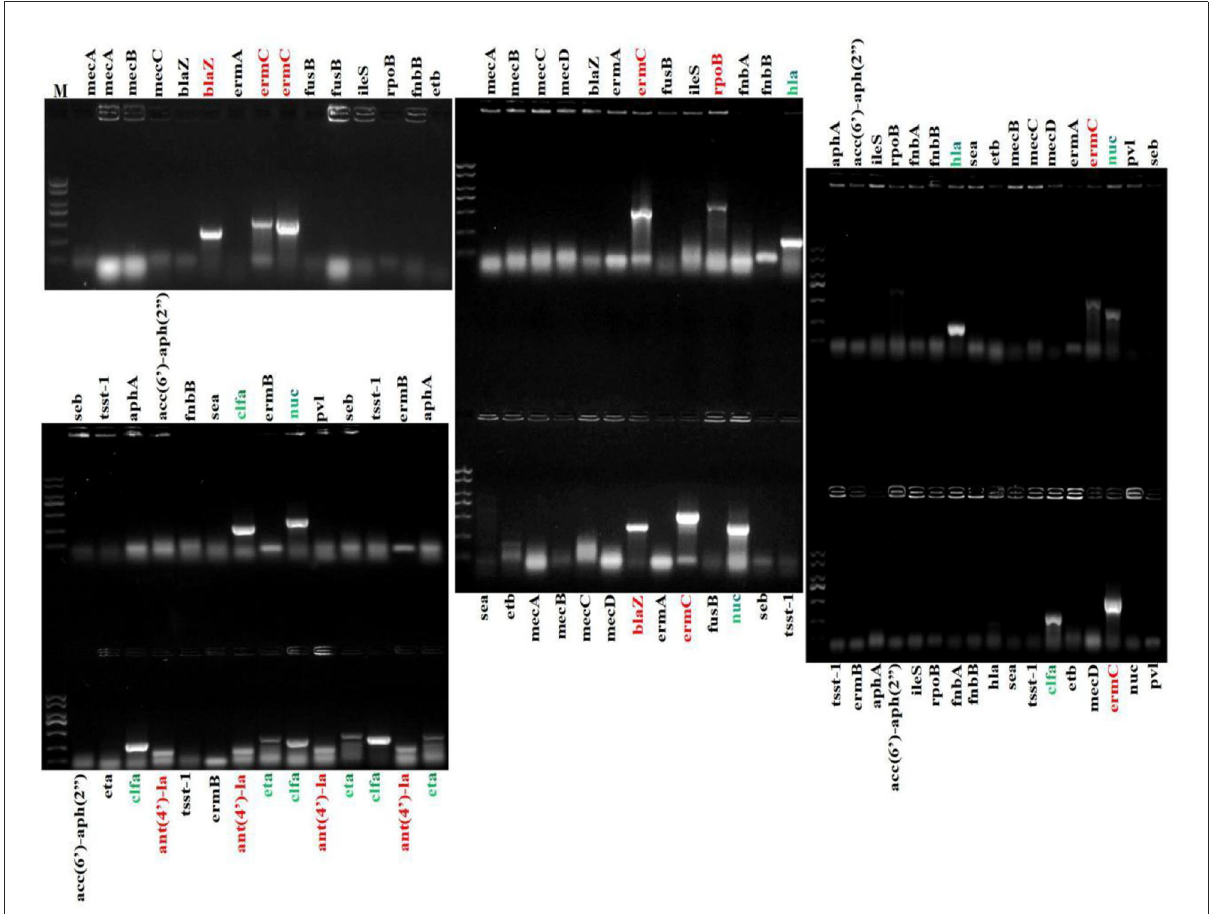
FIGURE5 Amplification of drug resistance genes and virulence genes of S. aureus . Marker ladder: 2,000, 1,500, 1,000, 750, 500, 250, and 100 bp.